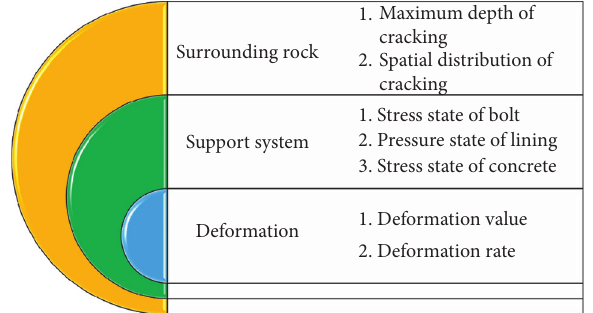
Figure 16: Multiple forms of warning